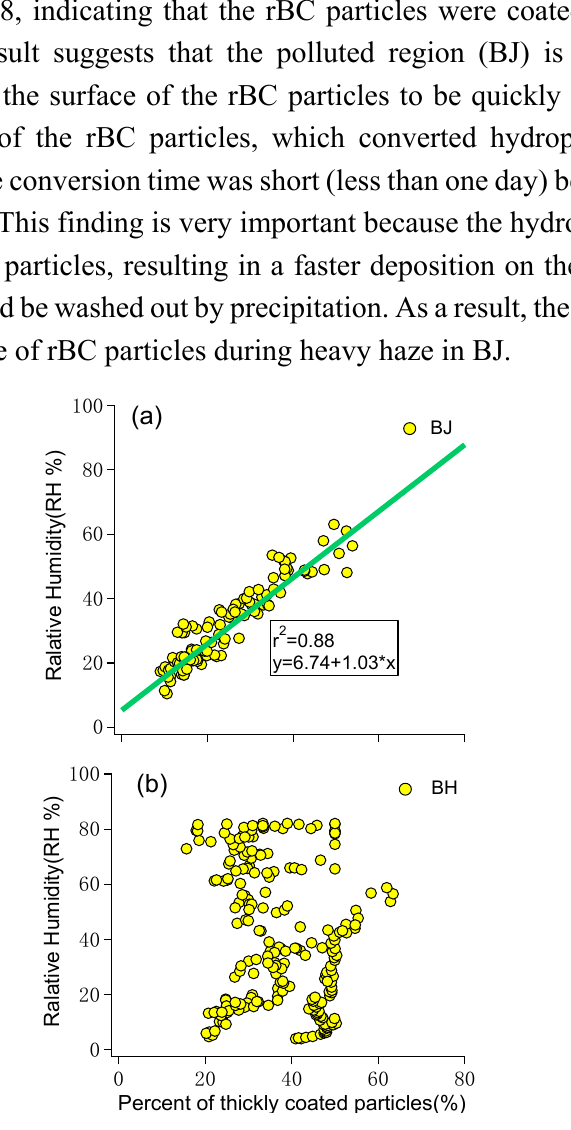
Figure 10. The correlation between the NF and RH in the two different regions. One was the large city (BJ-upper panel), and the other was the remote ocean region (BH-lower